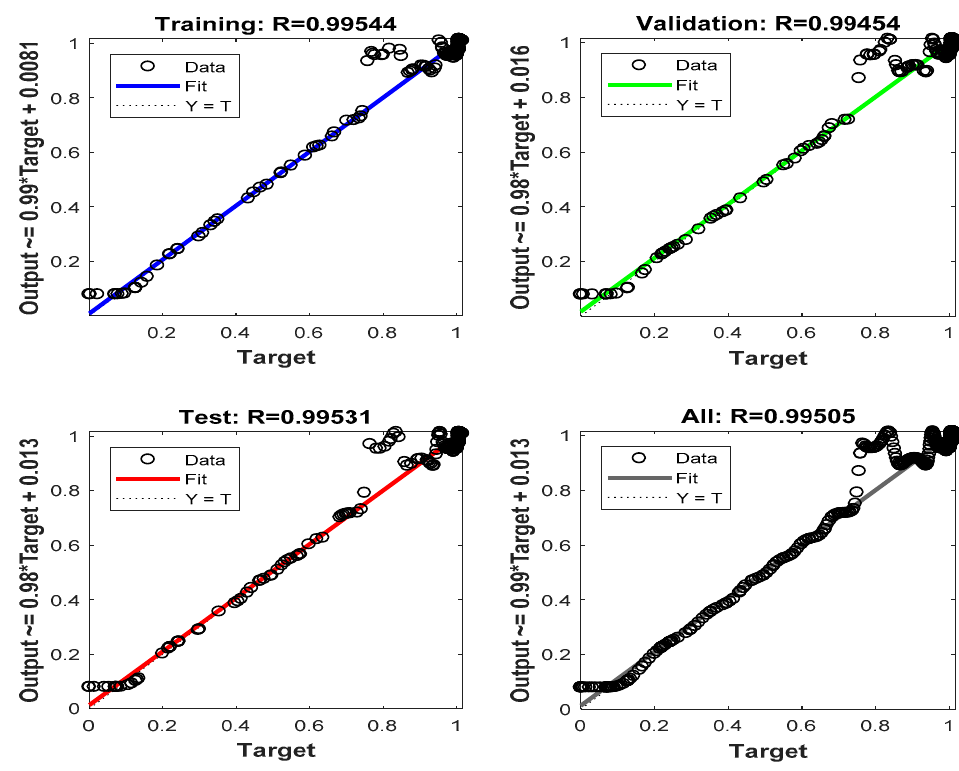
Figure 25. Bar chart of the depth plane control.